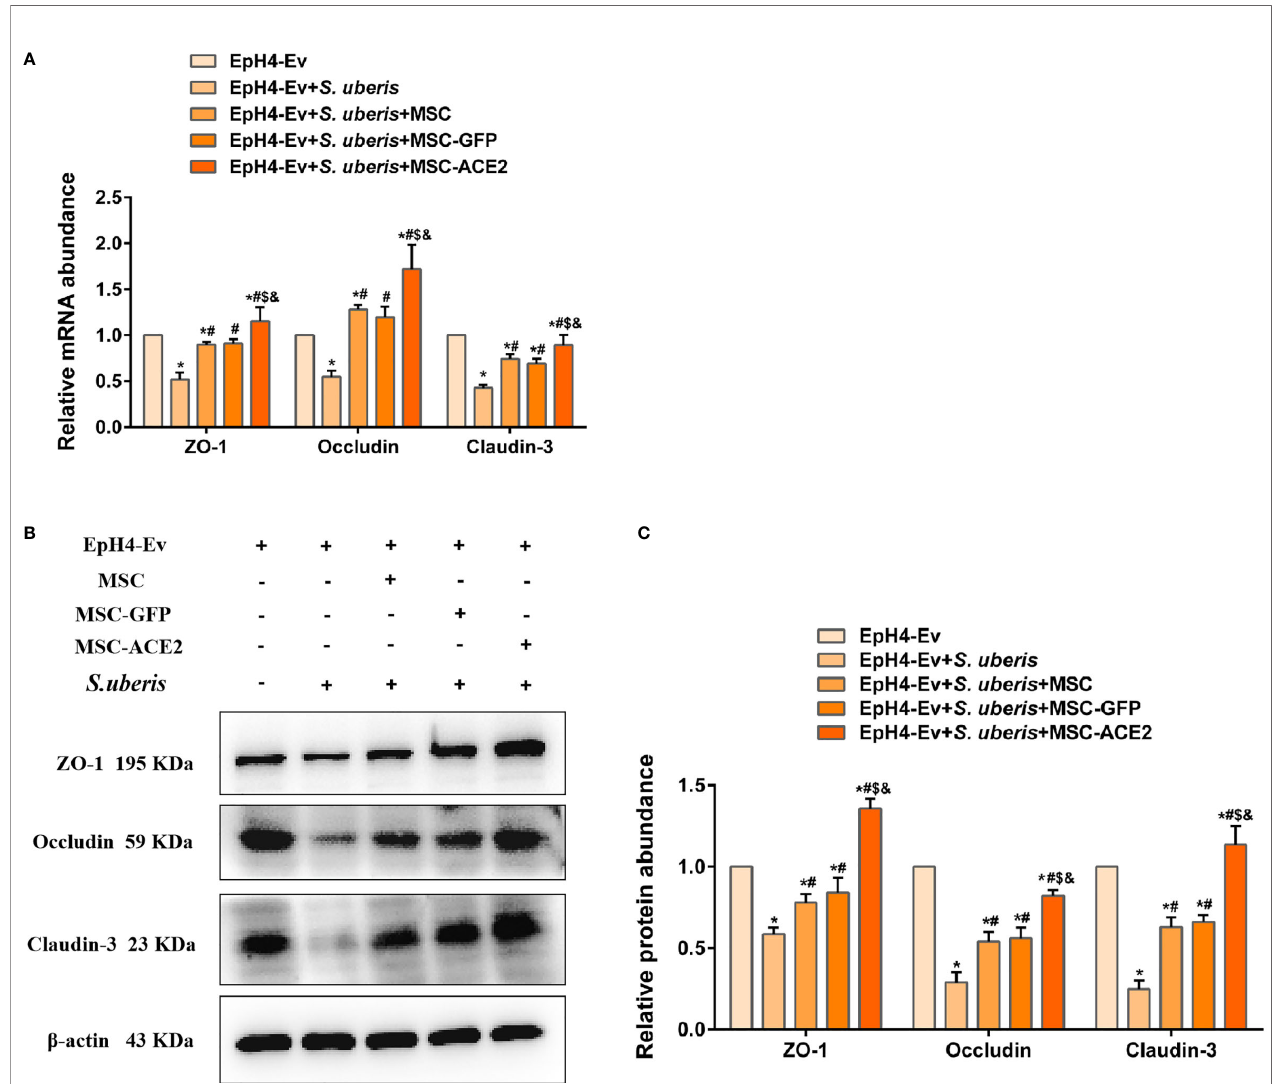
FIGURE 8 | MSC-ACE2 reversed the S. uberis -induced downregulation of the expression abundance of blood-milk barrier-associated proteins. (A) Detection of relative transcript levels of ZO-1, Occludin, and Claudin-3 in EpH4-Ev cells by qPCR (n = 4). (B) Detection of relative protein expression levels of ZO-1, Occludin, Claudin-3 by Western blot; (C) Statistics of the ZO-1, Occludin, Claudin-3 Western blot results (n = 3). Experiments were repeated three times and data were presented as the mean ± SEM. * P < 0.05 vs. EpH4-Ev; # P < 0.05 vs. S. uberis ; $ P < 0.05 vs. MSC; & P < 0.05 vs.